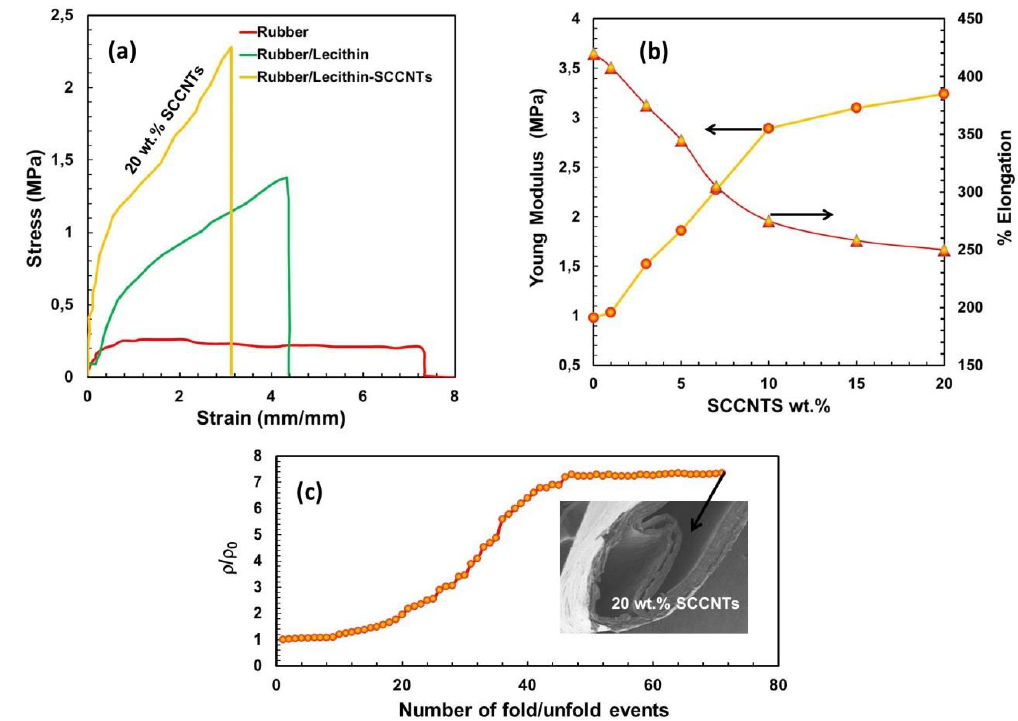
Figure 6. ( a ) Stress-strain behavior pure rubber and some select bio-nanocomposites before Figure6. ( a )Stress-strainbehaviorpurerubberandsomeselectbio-nanocompositesbeforeimpregnating impregnating into the cellulose membrane. As before, rubber/lecithin blend (matrix) is always into the cellulose membrane. As before, rubber / lecithin blend (matrix) is always maintained at 1:1 ratio. maintained at 1:1 ratio. ( b ) Changes in elastic modulus and elongation at break values as a function ( b ) Changes in elastic modulus and elongation at break values as a function of SCCNT concentration of SCCNT concentration in the rubber/lecithin matrices. ( c ) Folding/unfolding resistance of the 20 wt in the rubber / lecithin matrices. ( c ) Folding / unfolding resistance of the 20 wt % SCCNT-loaded % SCCNT-loaded bio-nanocomposite after impregnating into the cellulose fiber network bio-nanocomposite after impregnating into the cellulose fiber network (membrane).